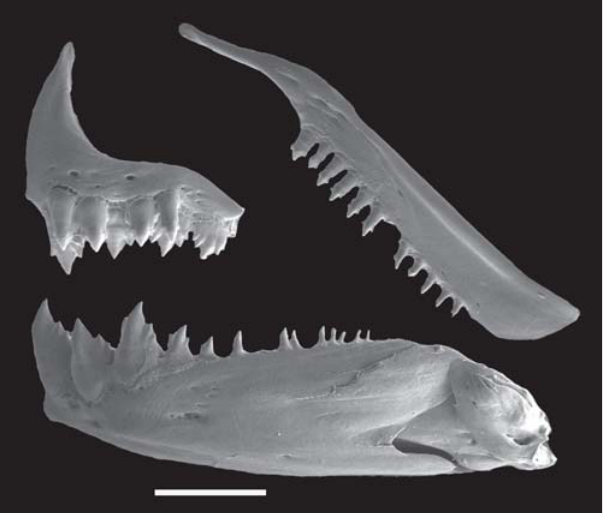
Fig. 13. Hemibrycon jelskii , MUSM 19562, male, 52.1 mm SL. Scanning electron micrograph of left side upper and lower jaws. Scale bar = 1